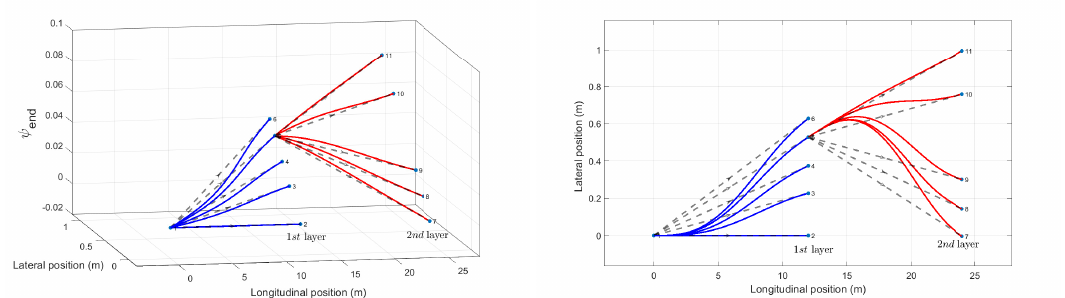
Figure 3. An example for the